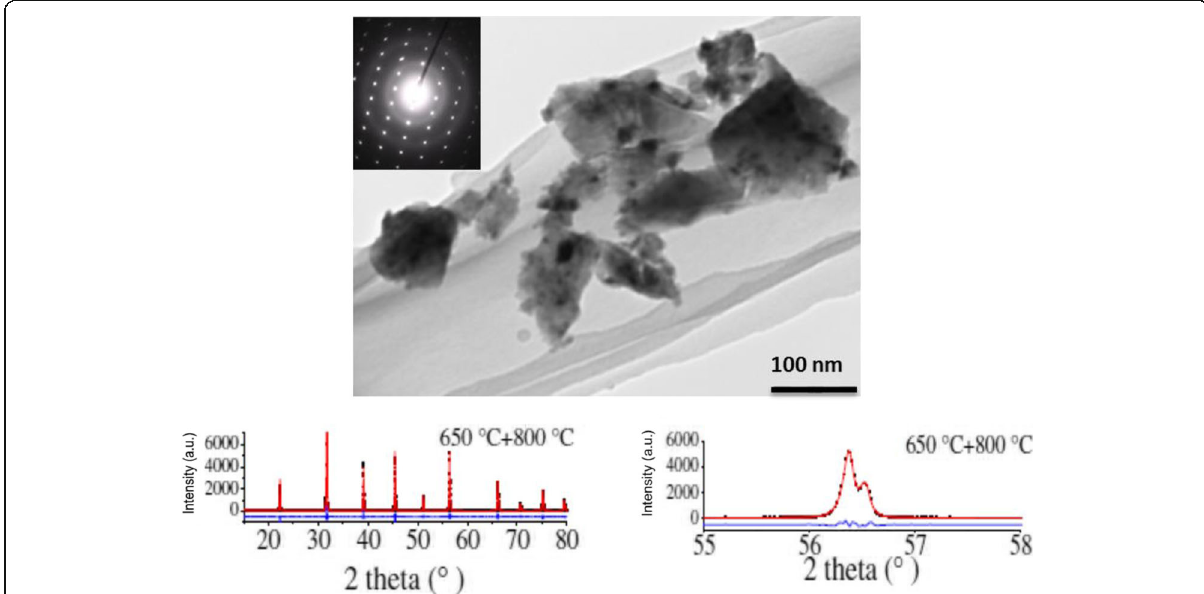
Fig. 7 TEM, XRD, and diffraction pattern of KF-BaTiO 2. TEM, the diffraction pattern, and XRD scan of KF-BaTiO 3 calcined at 800 °C as performed in 25. The nanoparticles range in size from 70 to 200 nm with a lattice constant of 3.99145 A ̊